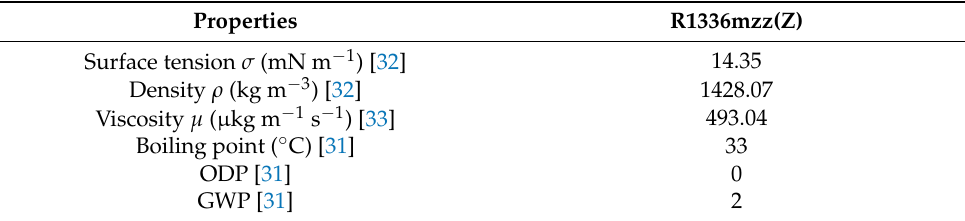
Figure 1. Schematic of the experimental system. Table 1. Properties of R1336mzz(Z) (5 ◦ C,1 Table 1. Properties of R1336mzz(Z) (5 °C,1 atm).